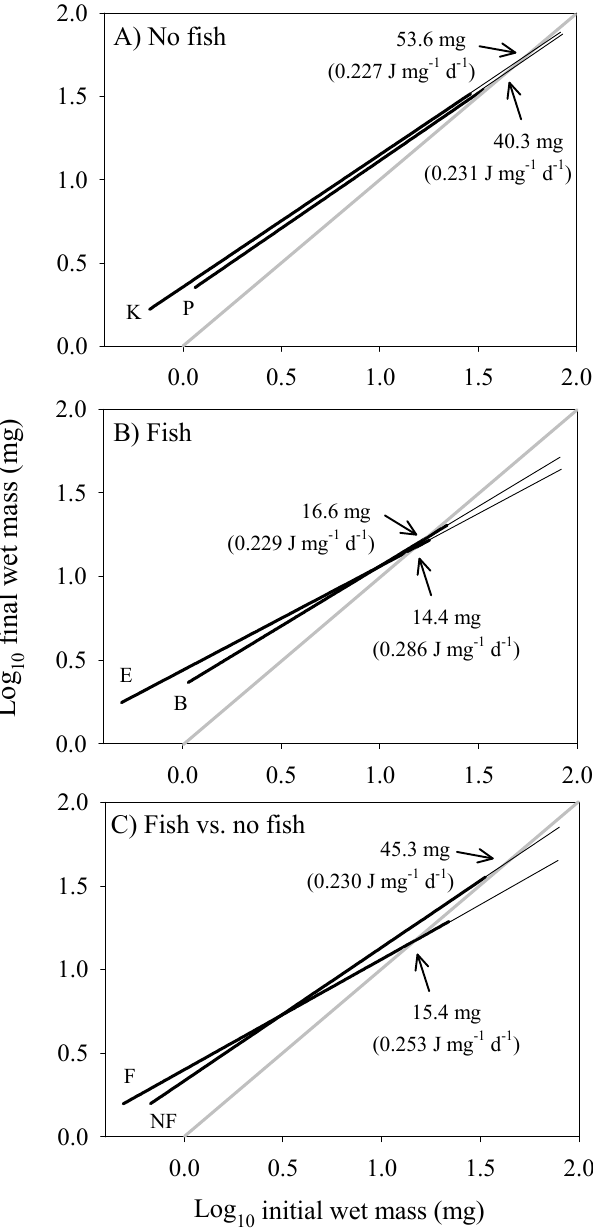
Figure 7. Estimation of the mass-specific cost of body maintenance (J mg − 1 d − 1 , in parentheses), which is based on the resting metabolic rate at the wet body mass (mg, as shown) at which growth ceases (as indicated by the gray line), as derived from three sets of empirical scaling relationships: final wet mass versus initial wet body mass after a 3 wk culture period (solid black lines), resting metabolic rate versus dry body mass, and dry body mass versus wet body mass for four populations of the amphipod Gammarus minus ([13]; and Appendix B). The methods used are described more fully in Section 2.8. The thin black lines represent extrapolations of the growth scaling relationships beyond the body-mass ranges sampled. Shown are comparisons of data for amphipods from the springs without fish predators (P = Petersburg; K = Kanesatake) ( A ), from the springs with fish predators (E = Ell; B = Blue) ( B ), and the collective data from the pairs of springs with versus without fish predators ( C ). Note that the estimated maximal body mass is significantly smaller in the springs with versus without fish, as is observed. The 95% confidence intervals for maximal body mass estimates, calculated using the 95% CI for the growth scaling slopes, are: K (46.8–61.1), P (33.0–49.4), E (13.0–16.0), B (14.4–19.1), F (14.1–16.7) and NF (40.5–50.8).